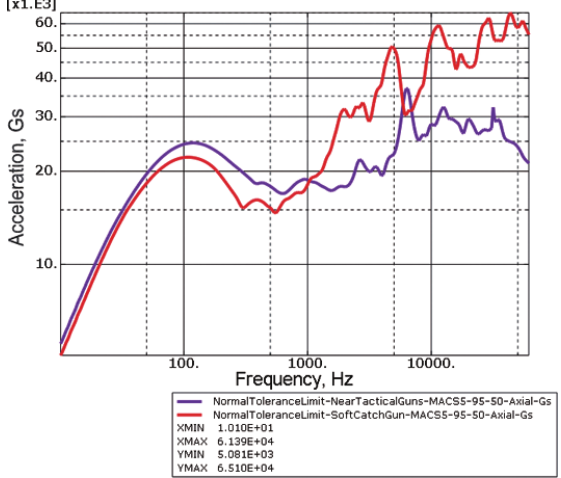
Fig. 12. Comparison of normal tolerance limits, MACS 5 charge, transverse, Q = 10. (Pink curve is for the Soft Catch Gun; Blue curve is for the near-tactical shots).